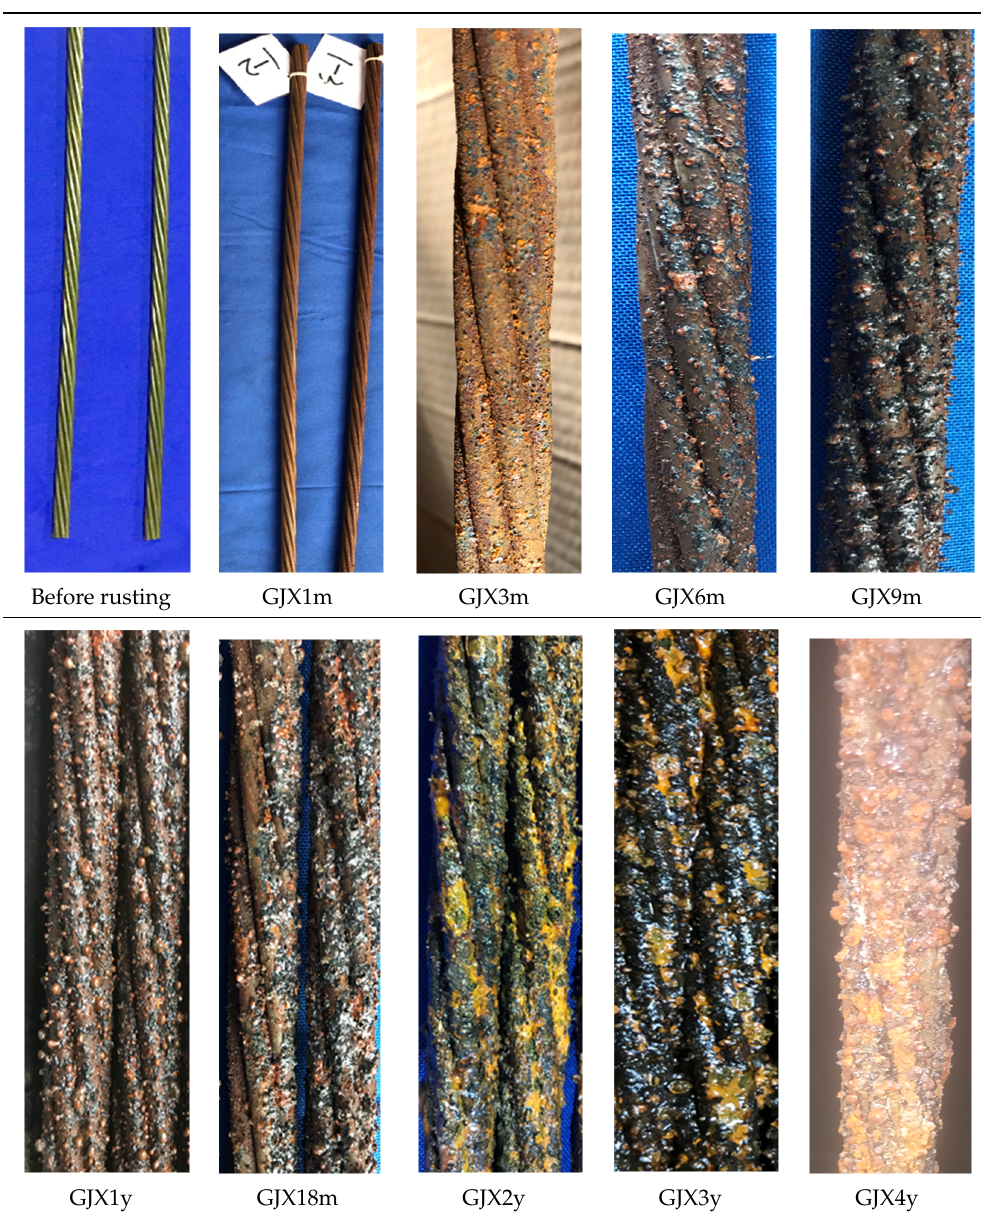
Table 2. Corrosion of unstressed steel strands at different corrosion times.